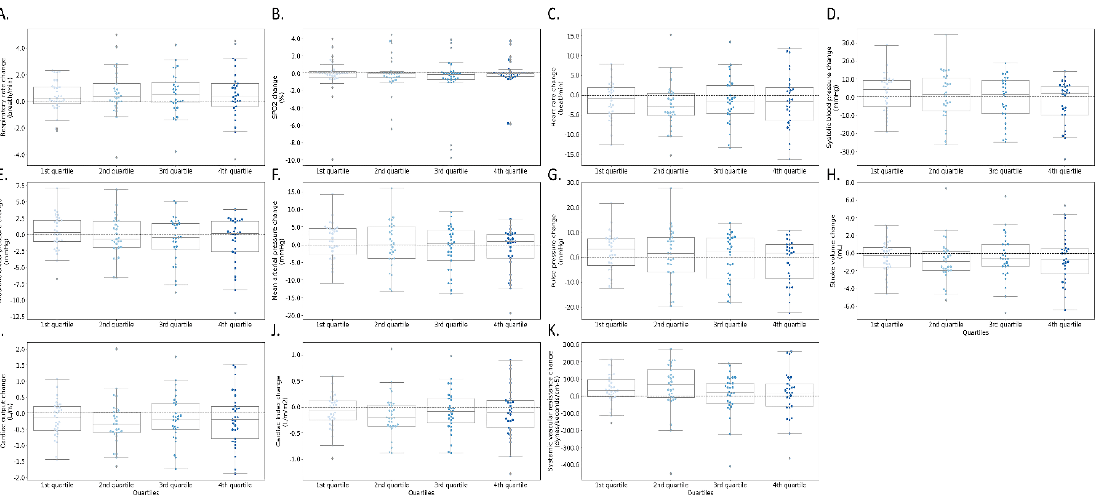
Figure 3. Relative changes from baseline in measured parameters along the quartiles of diuretic treatment. ( A ) respiratory rate (RR), ( B ) blood oxygen saturation (SpO 2 – %), ( C ) systemic vascular resistance (dynes/sec/cm −5 ), ( D ) heart rate (beats per minute), ( E ) stroke volume (milliliters), ( F ) cardiac output (liter/minute), ( G ) cardiac index (liter/minute/body surface area), ( H ) systolic blood pressure (mmHg), ( I ) diastolic blood pressure (mmHg), ( J ) pulse pressure (mmHg), ( K ) mean arterial pressure (mmHg).